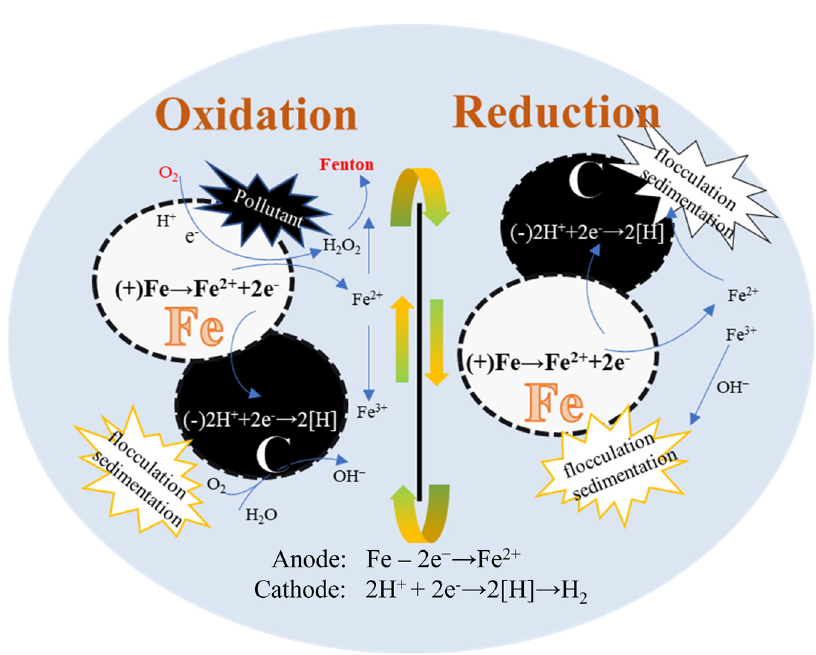
Figure 1. Schematic diagram of the iron-carbon micro-electrolysis principle.